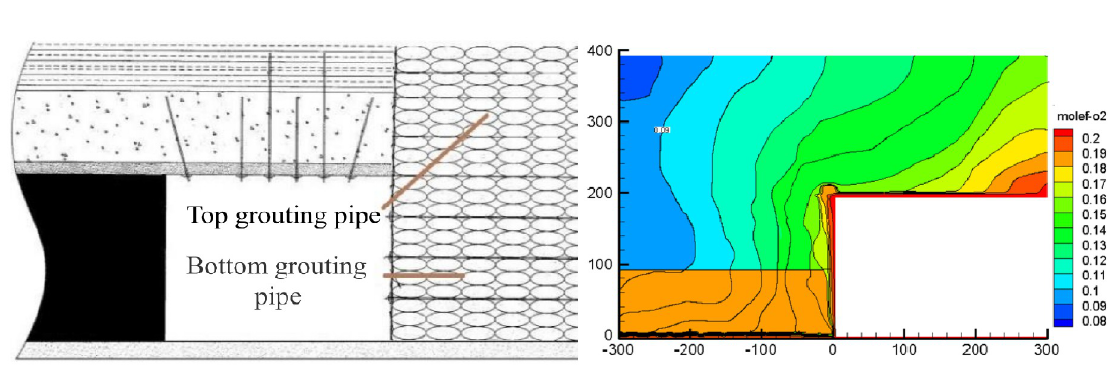
Fig 13. Grouting measures and oxygen distribution in the goaf after ideal grouting.